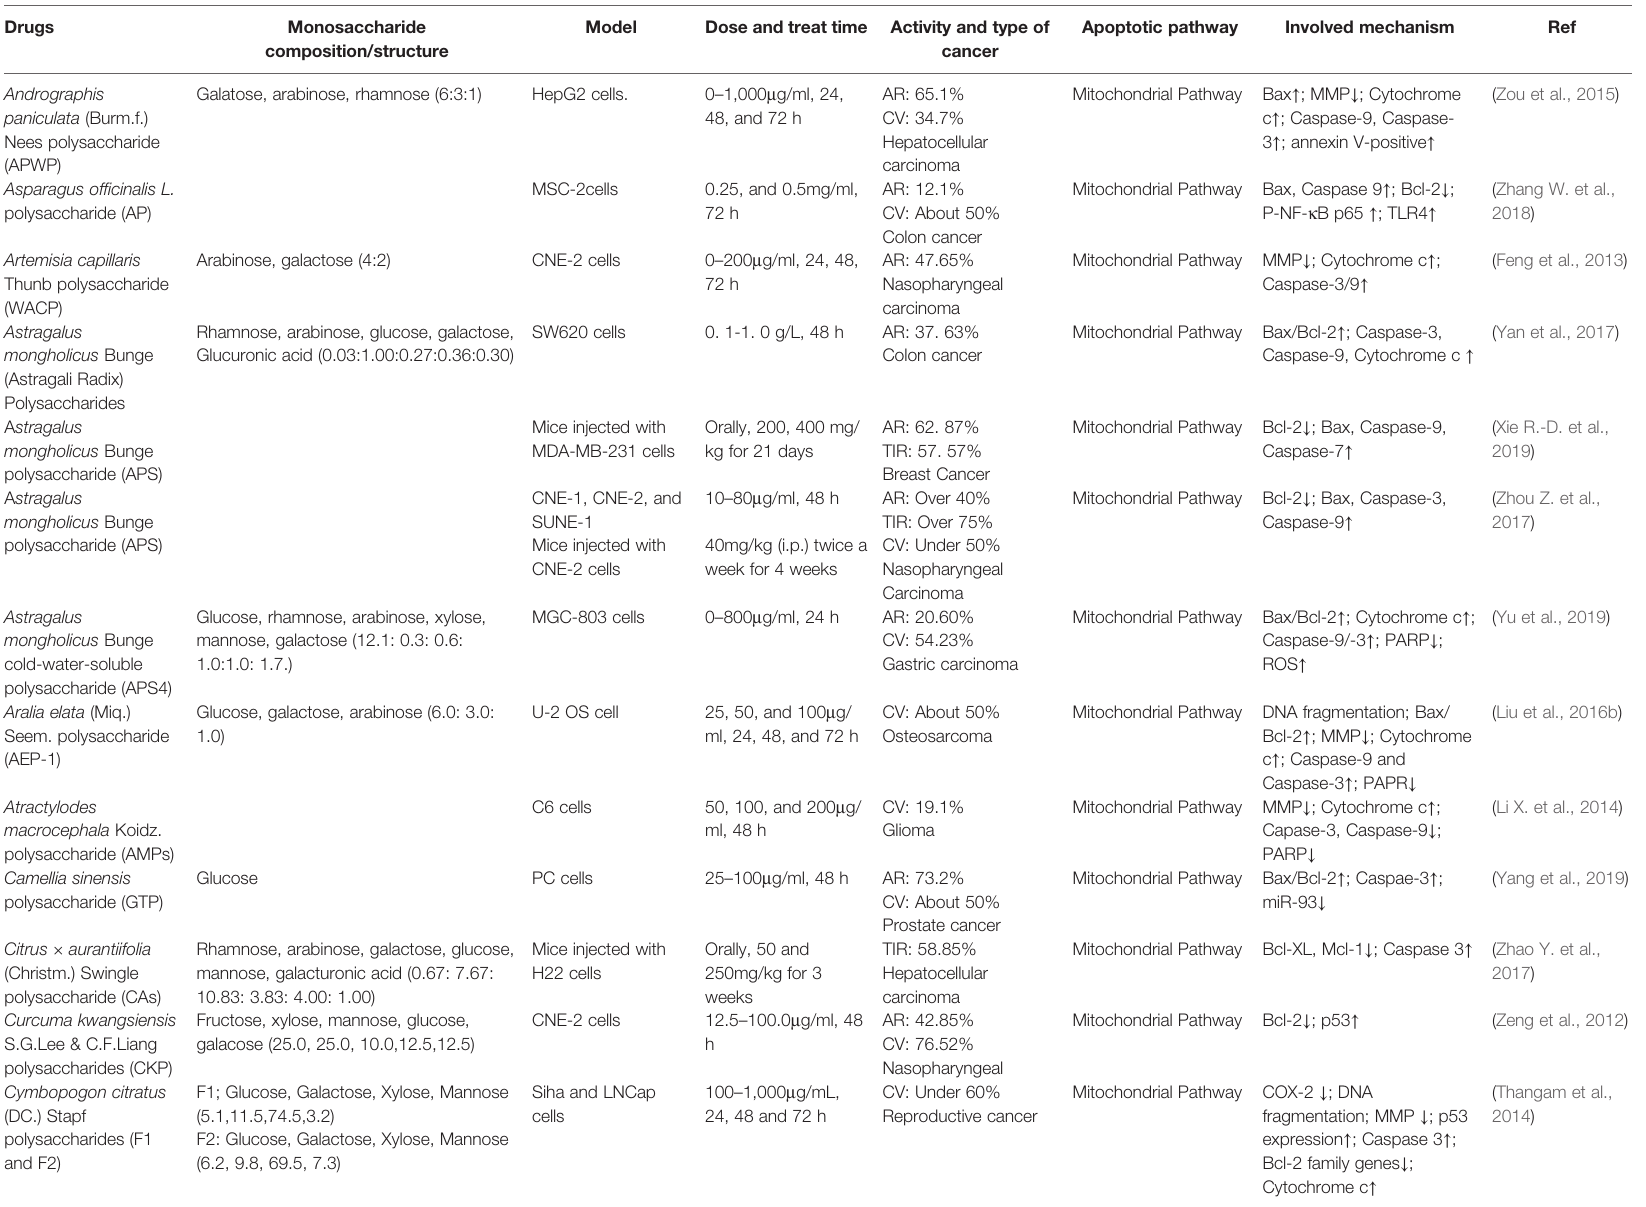
TABLE 1 | Effects of plant polysaccharides on apoptosis in